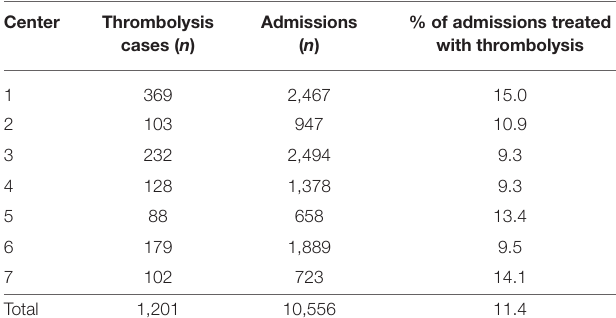
TABLE 1 | Number of thrombolysis treatments, number of admissions with acute ischemic stroke, and thrombolysis rate for each center during audit